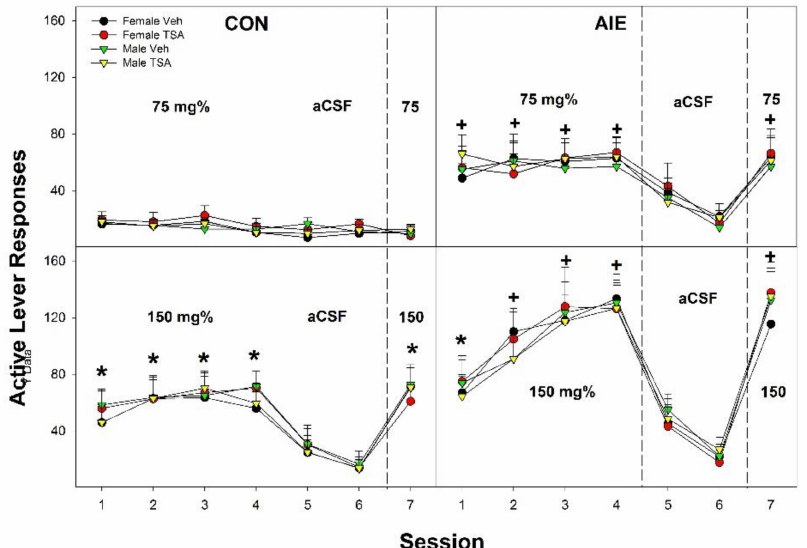
Figure 7. Active lever responses in male and female Wistar exposed to CON or AIE during adoles- cence and pretreatment/treatment with the HDAC inhibitor Trichostatin A (TSA) before testing for EtOH self-administration into the posterior VTA during adulthood. * indicates lever discrimina- tion between active and inactive lever and significantly more responding than 75 mg% CON rats. + indicates lever discrimination between active and inactive lever and significantly more responding than AIE rats compared to CON rats (at that EtOH concentration. Data are mean ± SEM.